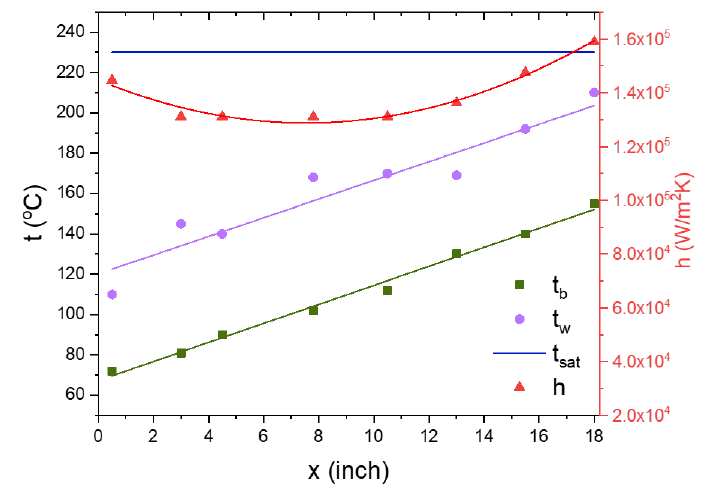
Figure 10: Results of the run 8, test 7 from the Gambill Test report. Here, t are referred to bulk (fluid) temperature, wall temperature, saturation temperature and heat